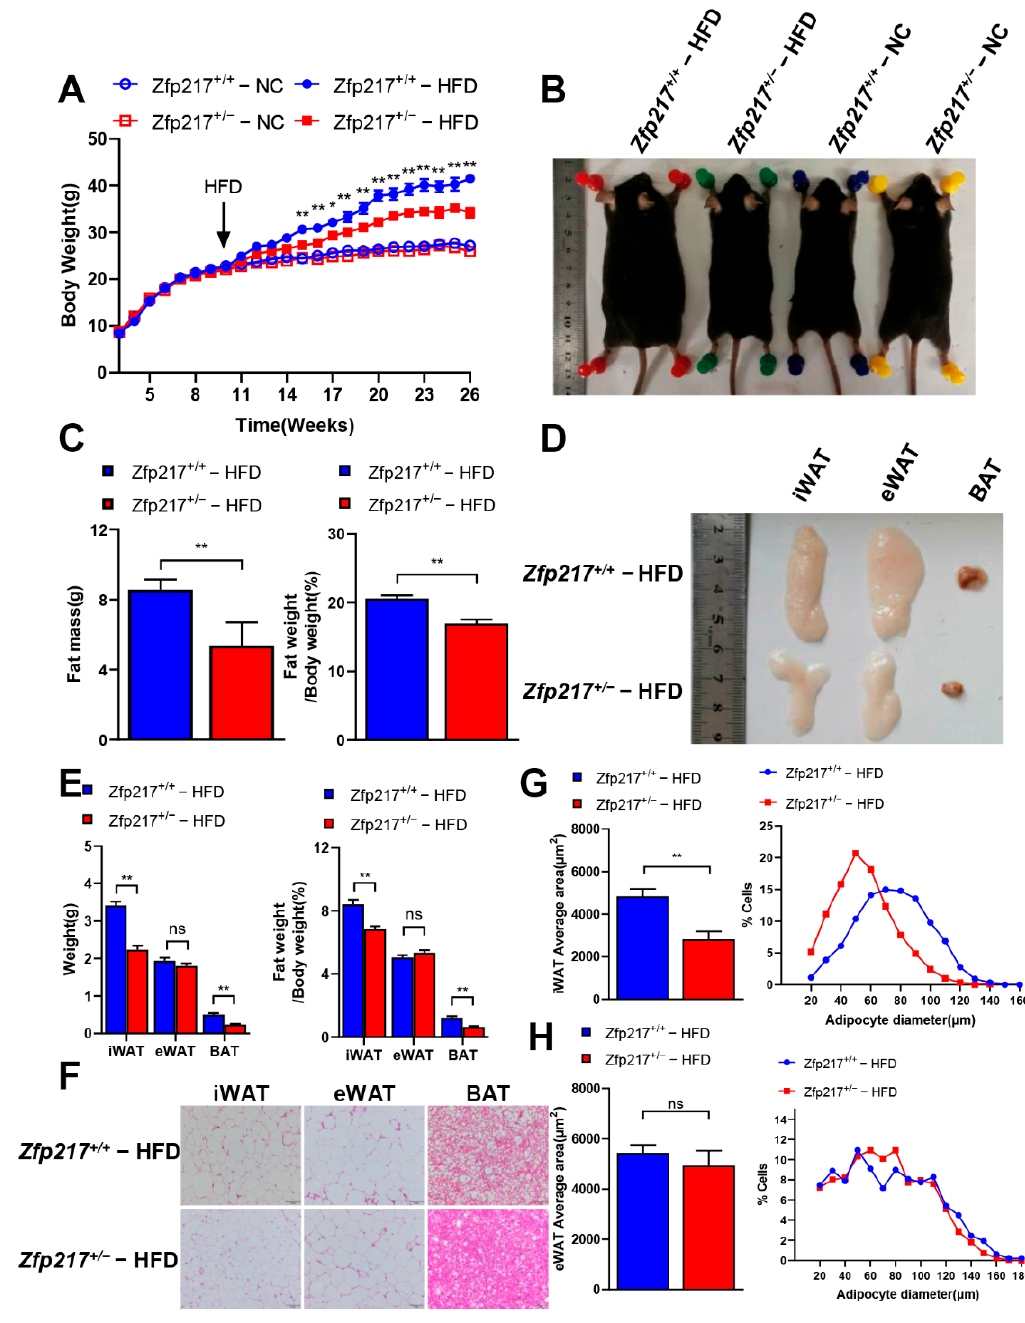
Figure 2. Zfp217 +/ − mice are resistant to high-fat diet-induced obesity. ( A ) Body weight of Zfp217 +/+ and Zfp217 +/ − mice fed a normal chow diet (NC) for 10 weeks and then switched to a high-fat diet (HFD) for 16 weeks ( n = 8 per group). ( B ) External appearance of representative Zfp217 +/+ and Zfp217 +/ − mice shown in A at 26 weeks. ( C ) Body fat weight or percentage of Zfp217 +/+ and Zfp217 +/ − mice ( n = 8 per group). ( D ) Gross appearance of adipose tissues from representative Zfp217 +/+ and Zfp217 +/ − mice shown in A at 26 weeks. ( E ) iWAT, eWAT, BAT weight or percentage of Zfp217 +/+ and Zfp217 +/ − mice ( n = 8 per group). ( F ) H&E staining of adipose tissue from Zfp217+/+ and Zfp217 +/ − mice (Scale bar: 100 µ m) ( n = 6 per group). ( G , H ) Average cell area ( left ) and adipocyte size distribution ( right ) in iWAT ( G ) and eWAT ( H ) of Zfp217 +/+ and Zfp217 +/ − mice ( n = 6 per group). For all statistical plots, data are presented as the mean ± SEM. * p < 0.05; ** p < 0.01; ns indicates no significance between the two indicated groups.